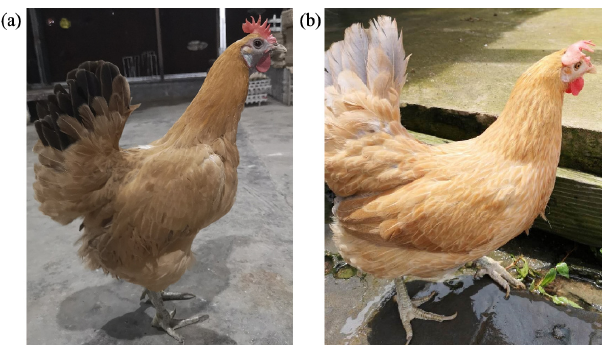
Figure 1. Xinyang blue-shelled pure-line layers: (a) dark-faced in- dividuals and (b) white-faced